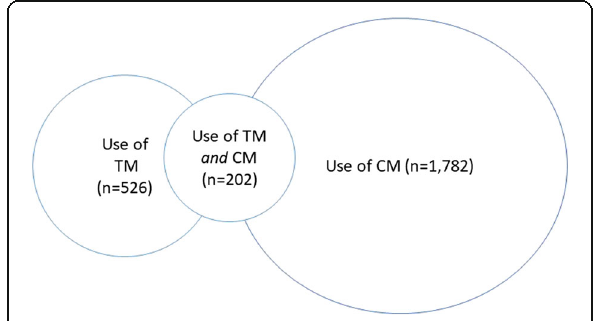
The total No visits to Visits to Visits to Visits to both TM population T&CM providers TM providers CM providers and CM